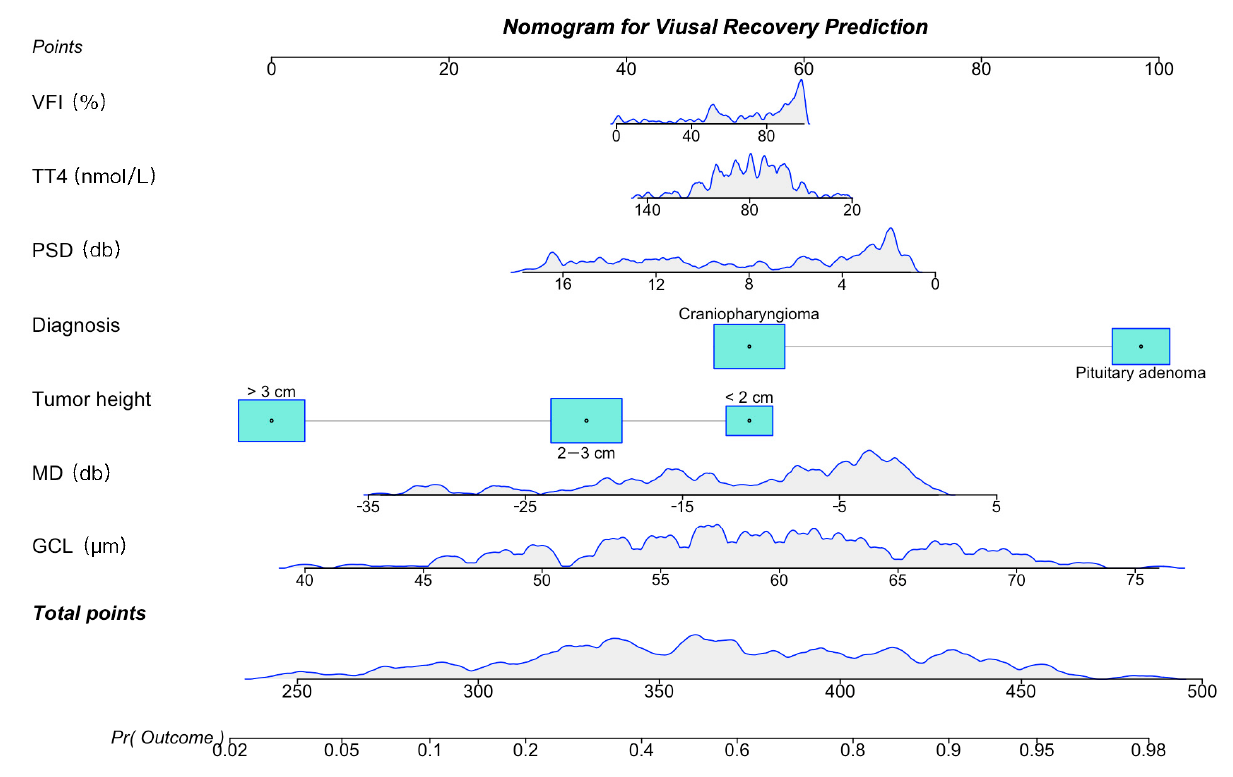
Figure 6. Nomogram for predicting visual outcome after transsphenoidal optic decompression. Physicians can add up corresponding scores using the graph and can obtain the recovery probability.